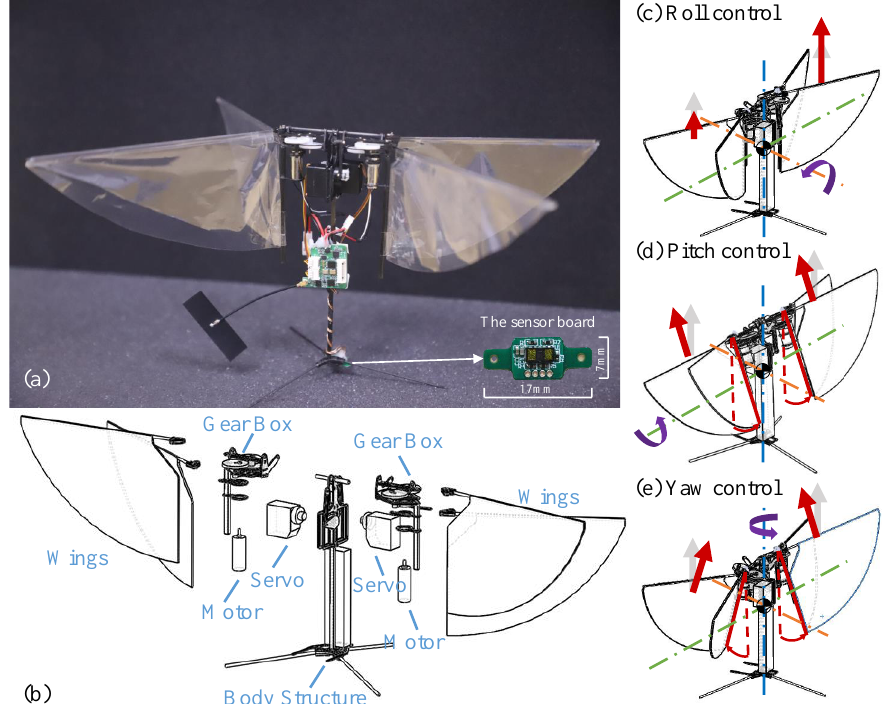
Figure 1. ( a ) Illustration of the lightweight FMAV. ( b ) Explosion diagram of mechanical structure. ( c – e ) Schematic diagram of control torque generation. Translucent arrows show the nominal wingbeat- average thrust vectors before torque generating. Solid arrows show wingbeat-average thrust and torque after torque generating.